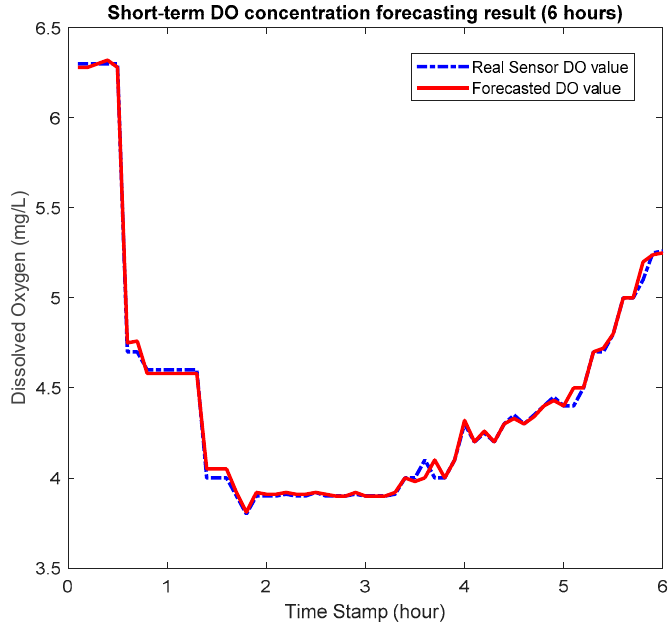
Figure 6. Short-term (6 h) forecast result measured against actual dissolved oxygen (DO) concentration values.